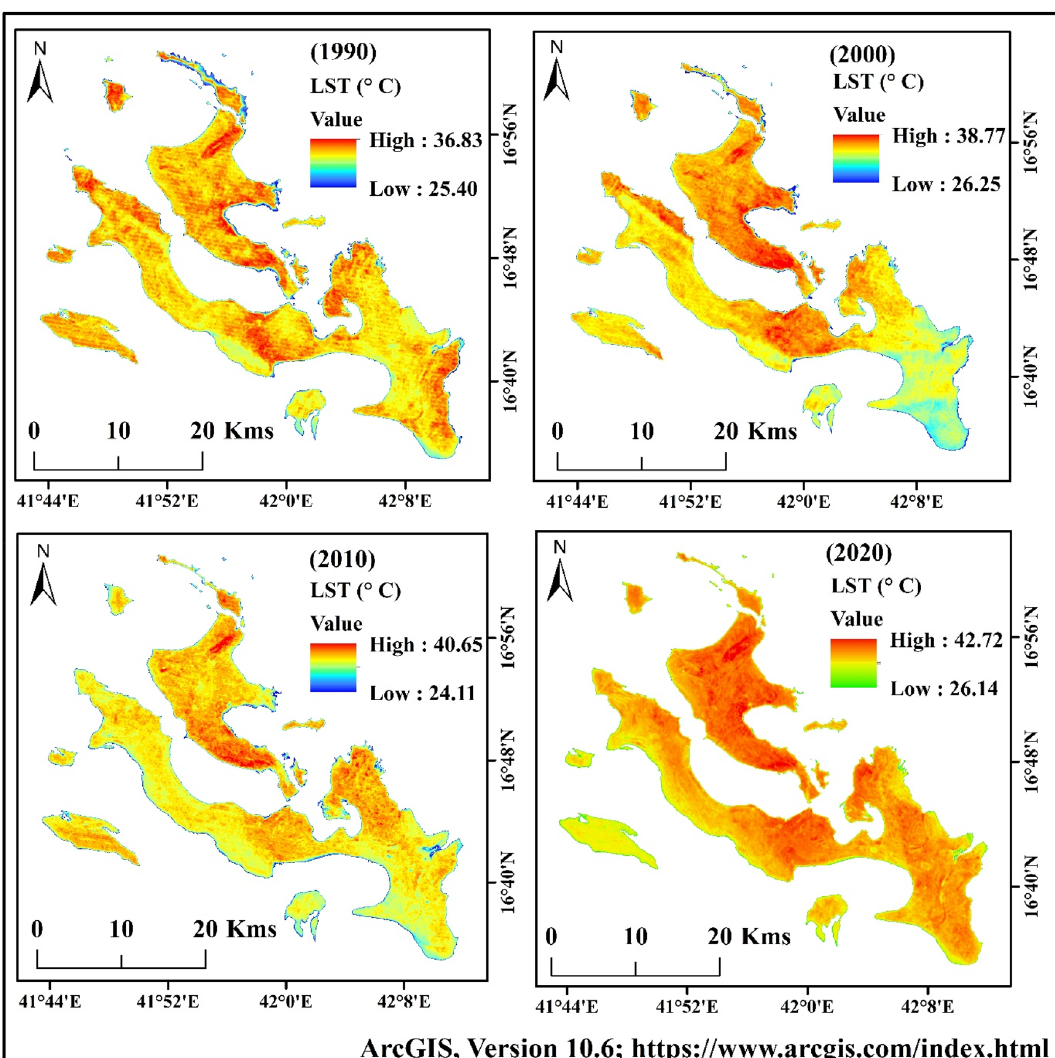
Figure 5. Land surface temperature (LST) maps of Farasan Islands for 1990, 2000, 2010, and 2020 31,64 . The satellite data was downloaded from USGS earth explorer (https:// earth explo rer. usgs. gov/). The map was generated using ArcGIS software, version 10.6 (https:// suppo rt. esri. com/ zh- cn/ produ cts/ deskt op/ arcgis- deskt op/ arcmap/